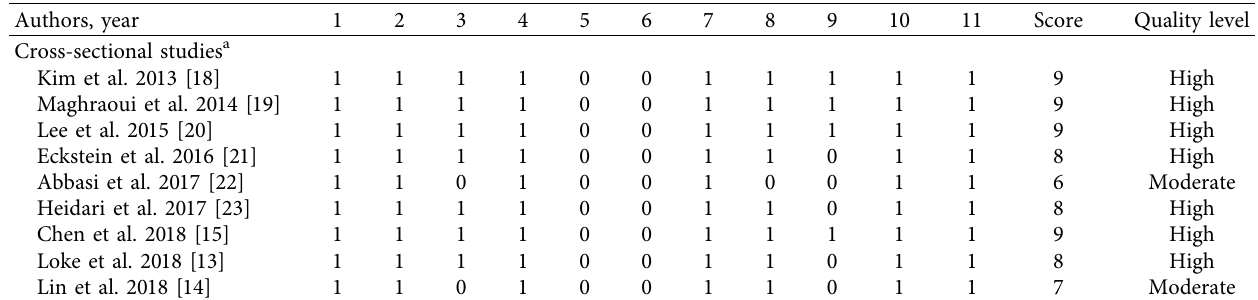
Table 3: The methodological quality of the included studies.